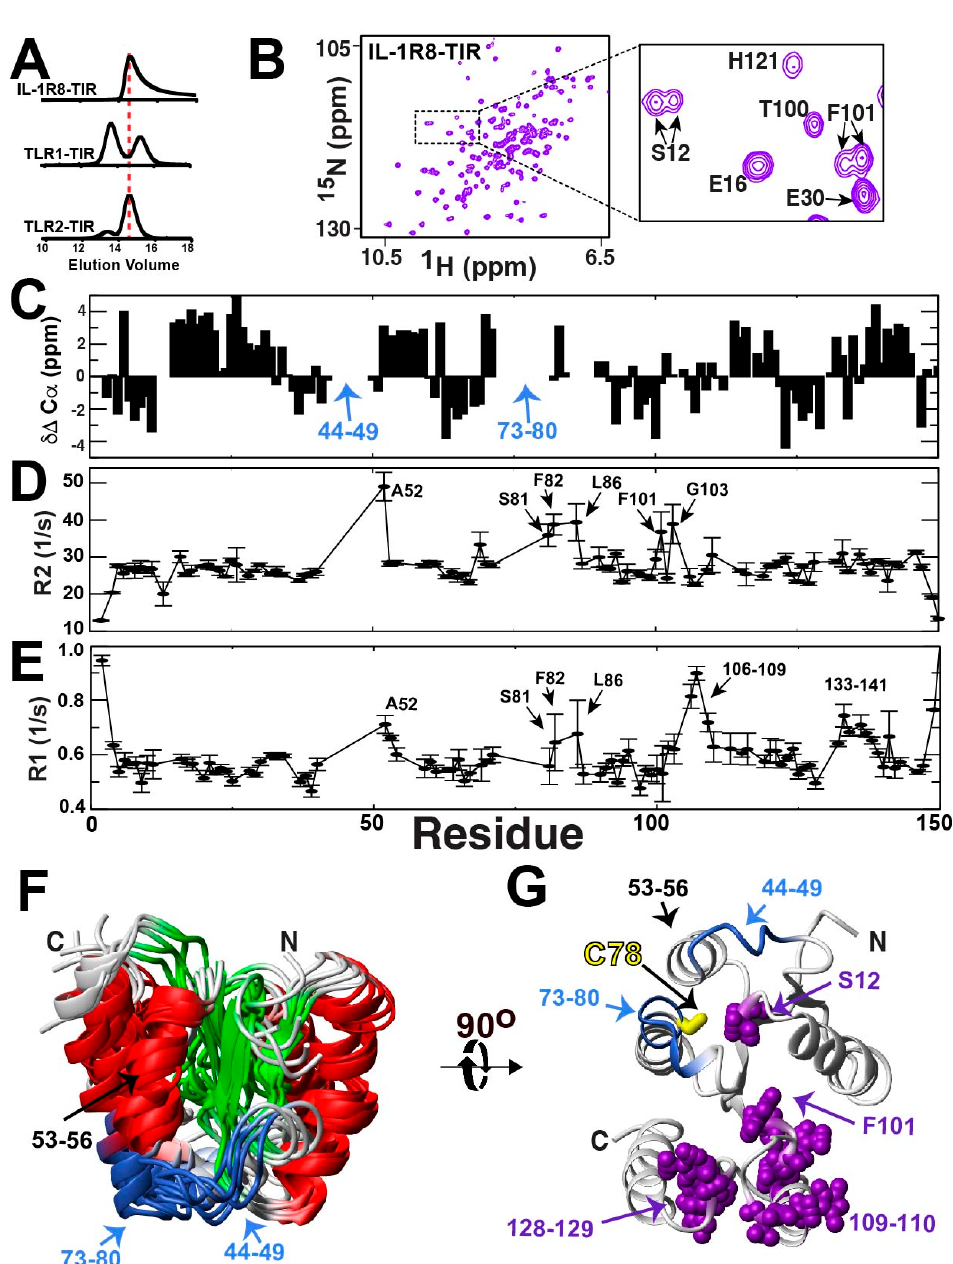
also highly dynamic within the ps–ns timescale, as indicated by their increased R1 relax-